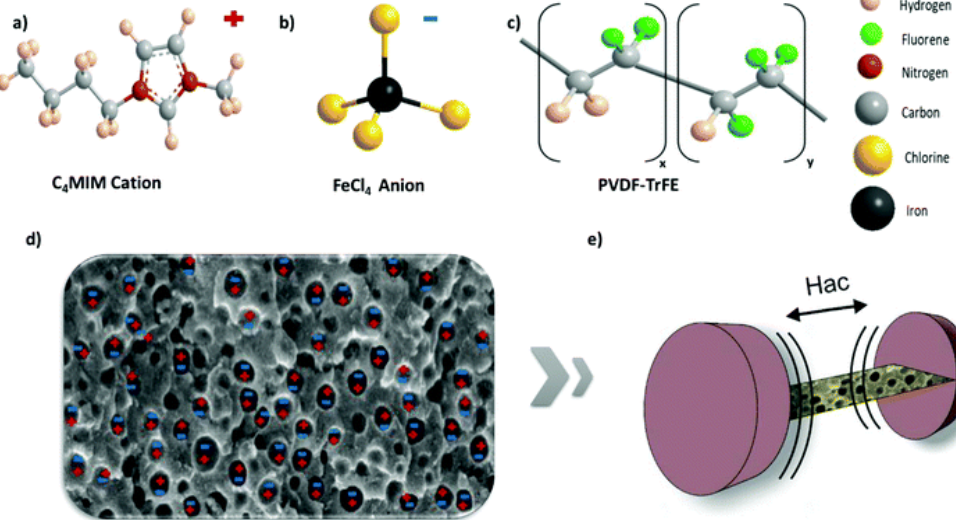
Figure 11. The MI nanocomposite and experimental set-up for the measurement of the MI effect. ( a ) Schematic representation of the [C 4 mim] + cation. ( b ) Schematic representation of the [FeCl 4 ]—anion. ( c ) Illustration of the P(VDF-TrFE) monomer structure. ( d ) Profile chart of the MI composite. ( e ) Schematic view of the system for MI voltage measurement. Reproduced with permission from [77] .